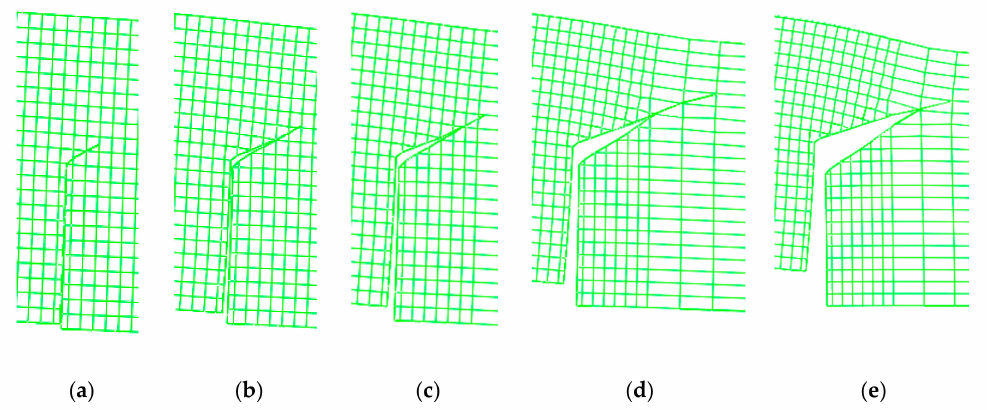
Figure 10. Crack propagation process (250 times magnification) with different incremental steps: ( a ) 57 step; ( b ) 86 step; ( c ) 92 step; ( d ) 117 step and ( e ) 142 step.